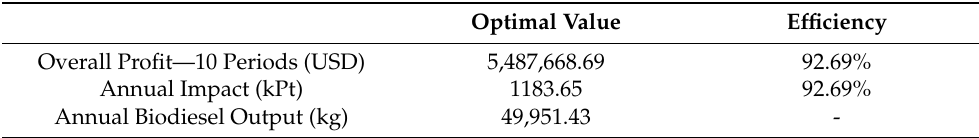
Table 3. Summary of multi-objective optimal results.